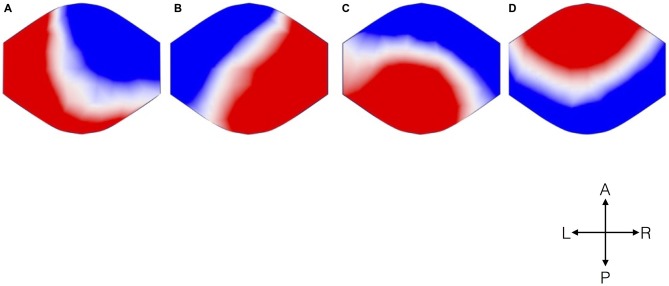
Topographical microstate maps. The figure shows the resulting four microstates, which are labeled (A–D) according to previous literature. The different colors signify the different polarities. The maps are represented as seen from above (A: Anterior, P: Posterior, L: Left, R: Right).